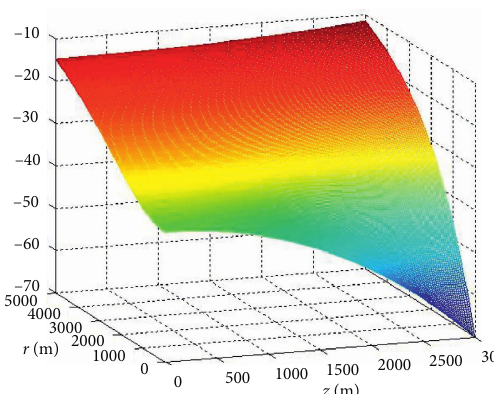
Figure 3: Approximate solution.